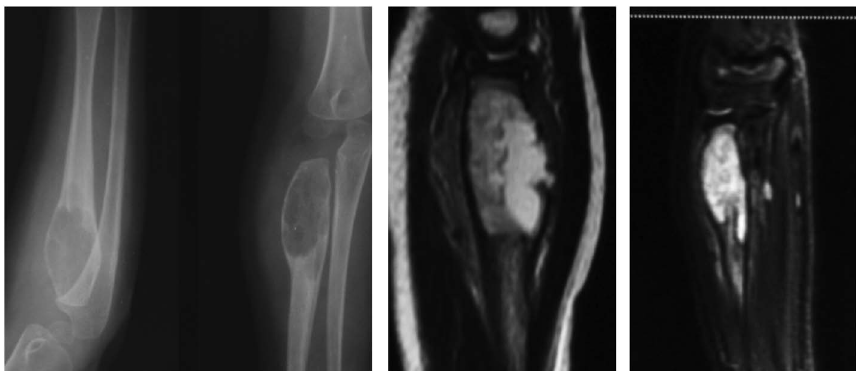
Figure 4. A 6-year-old female with a mass over the elbow and restricted range of motion was referred with an X-ray suggestive of a bone cyst. An MRI of the swelling showed a non-speci fi c enlargement with a break in the cortex, a biopsy and histopathology con fi rmed the presence of tuberculous infection in this patient.